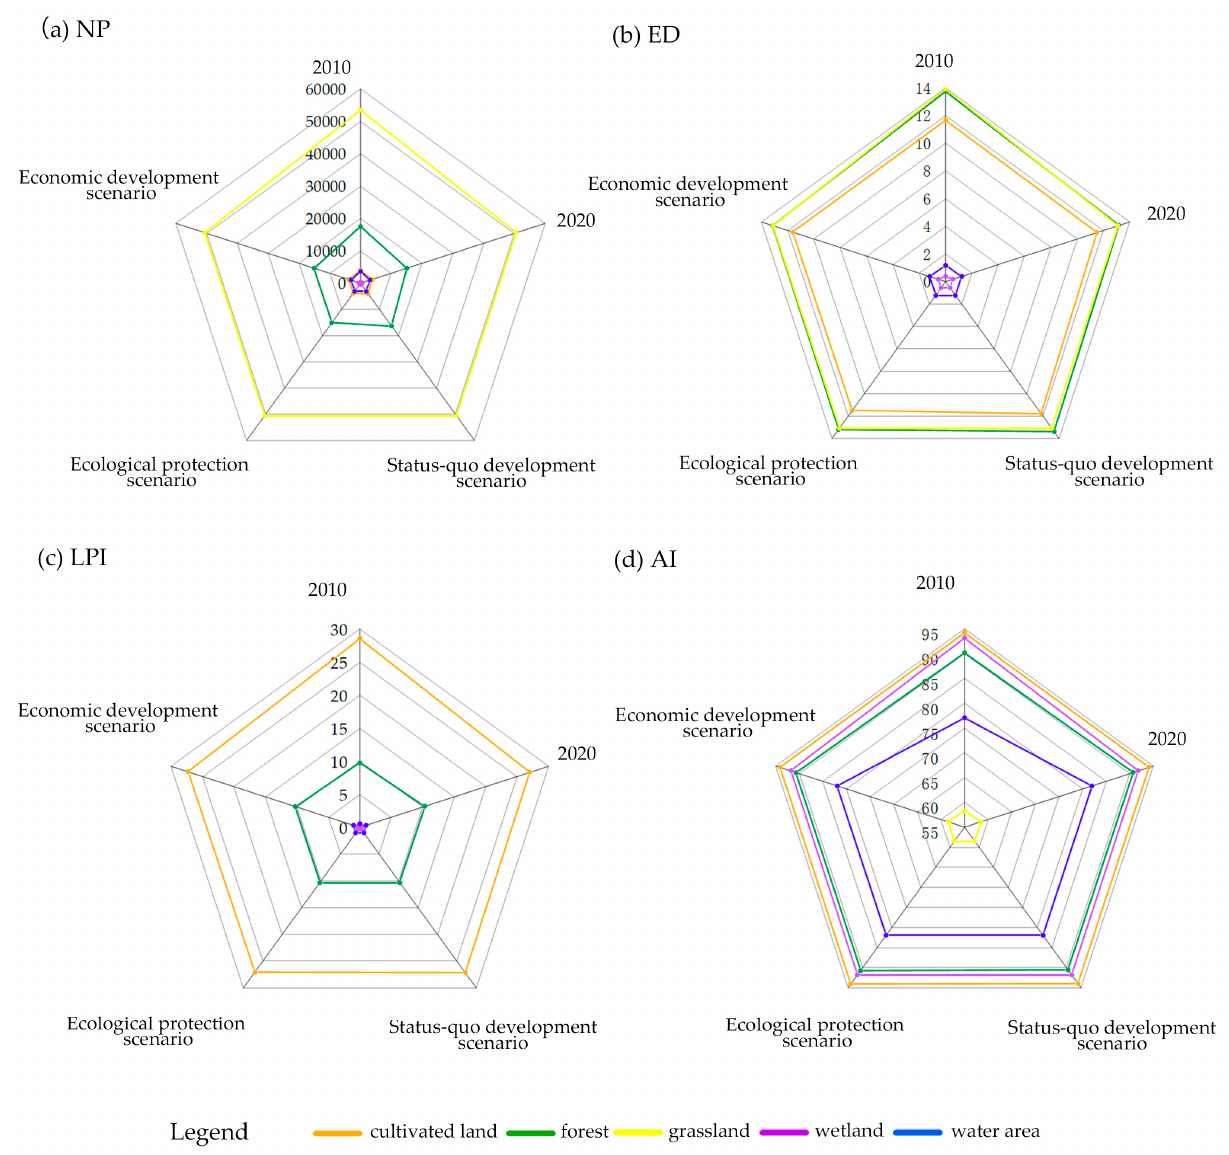
Figure 8. Class-level landscape indices in the study region.